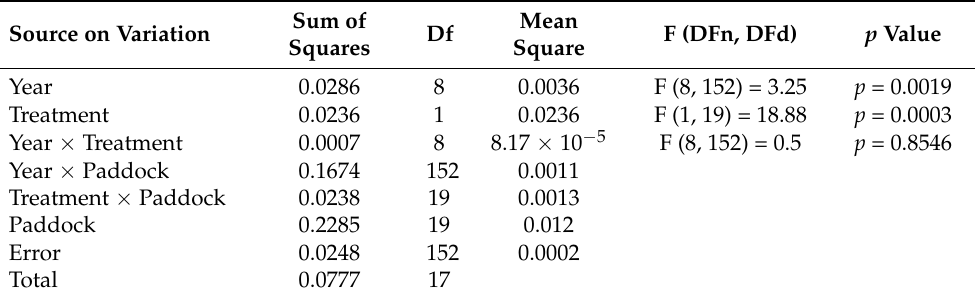
Table A3. Enhanced Vegetation Index (EVI) two-way repeated measure ANOVA of Natural Grassland (NG) and Natural Grasslands overseed with Legumes with Phosphorus fertilization (NG-LP), during 9 years after intensification practice ( n = 20).